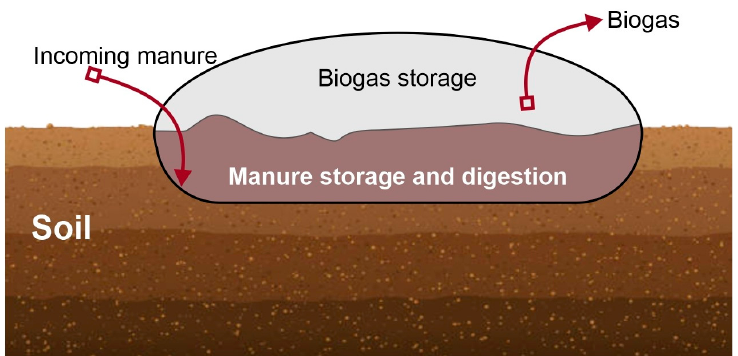
Figure 2. Covered Anaerobic